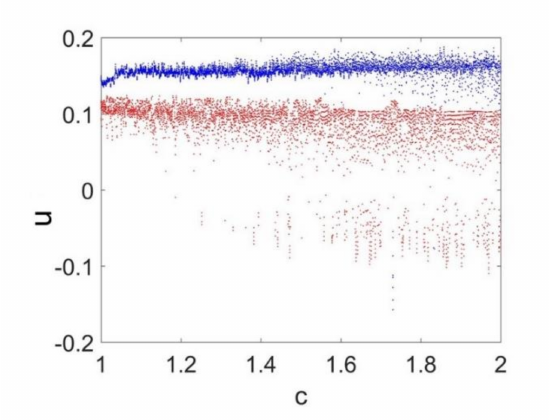
Figure 8. The coexisting bifurcation diagram for the system (4) with respect to c . The blue color trajectory of the system (4) corresponds to the initial state U 0 , while the red color trajectory of the system (4) corresponds to the initial state V 0 . When c = 1 and c = 1.5, the chaotic dynamical system (4) exhibits two types of coexisting chaotic attractors in Figure 9a,b, respectively.